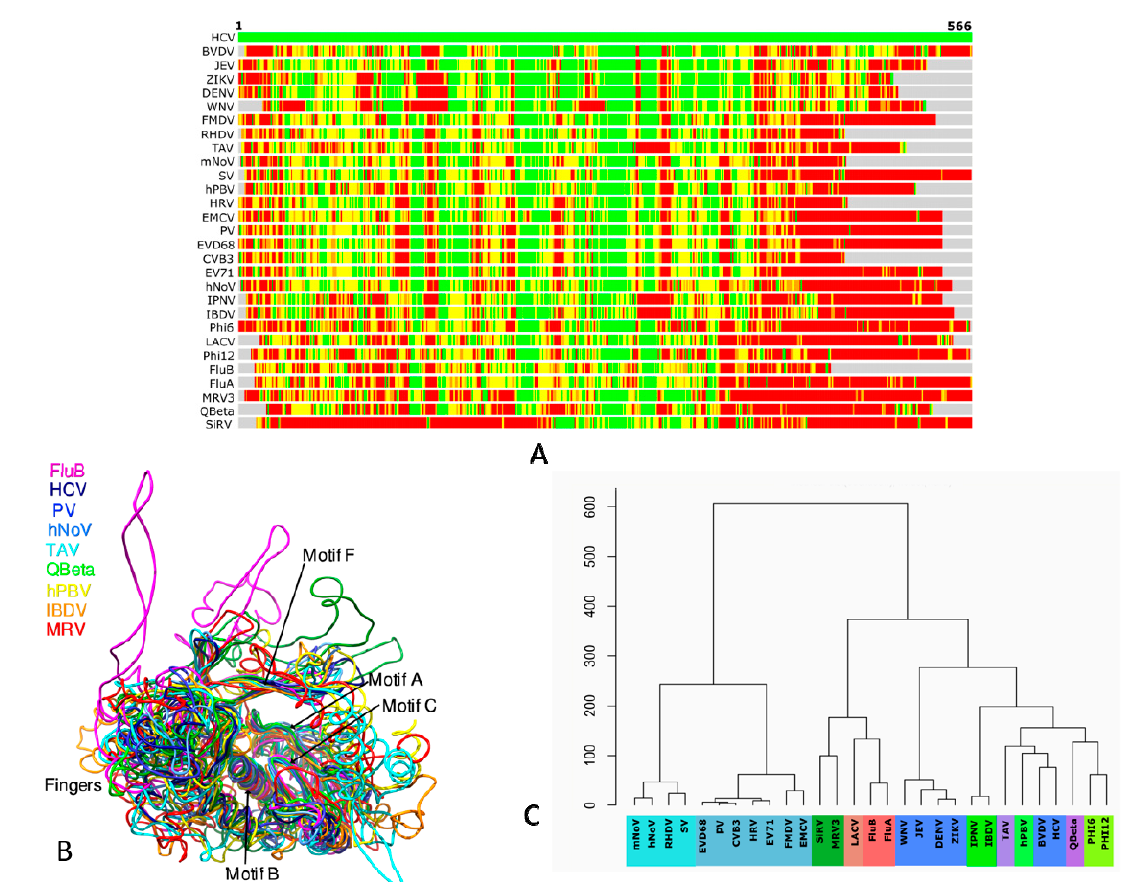
Figure 3. Structure-based alignment and phylogeny of representative RdRps listed in Table 1 (excluding VSV and BmCPV) using STRALCP server run with default parameters [89]: ( A ) Structural alignment of the RdRps of BVDV (PDB ID: 2cjq) [33,34], West nile virus (WNV) (PDB ID: 2hcn) [80], DENV (PDB